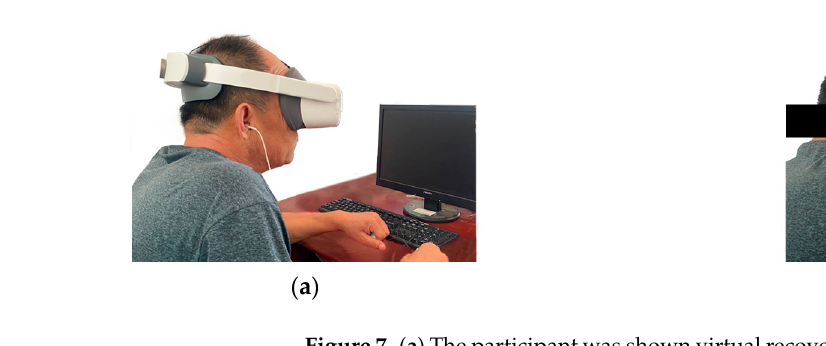
Figure 6. Detail steps of the experimental module.